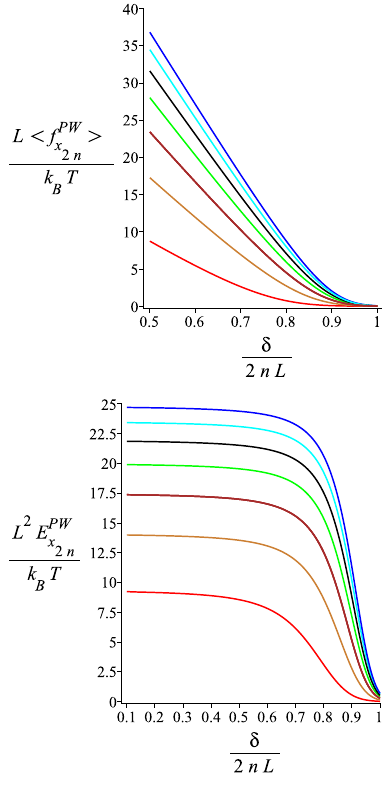
Figure 16. The first panel : The dimensionless force of the structure with an even number of arms exerted on the confining wall as a function of the dimensionless distance of the wall from the grafting point. The second panel : The dimensionless differential stiffness of the system with an even number of arms as a function of the dimensionless distance of the wall from the grafting point. The red, gold, brown, green, black, cyan, and blue are associated with the fixed values for the magnetic interaction K B = 0,3, 6,9,12, 15,18, respectively. The other fixed parameters are: ω = π = 12.5. The red dashed line is associated with θ = π and l p L